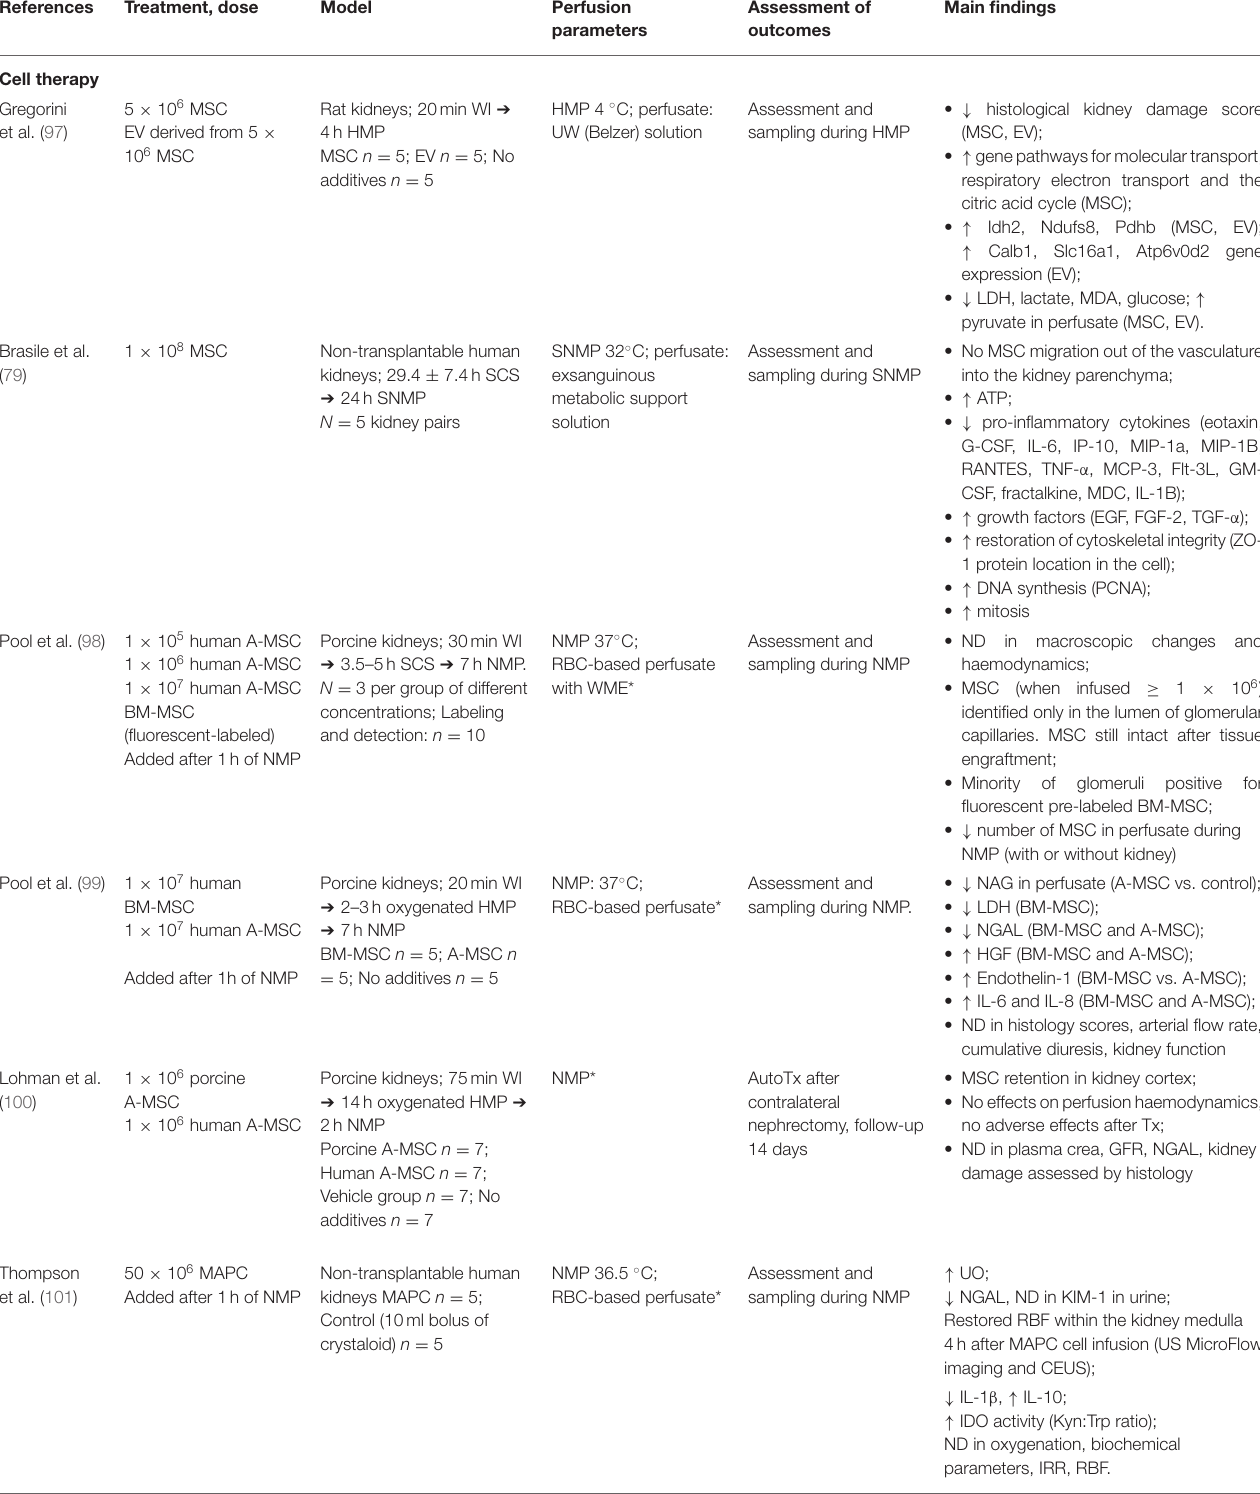
TABLE 2 | Summary of kidney ex-vivo perfusion